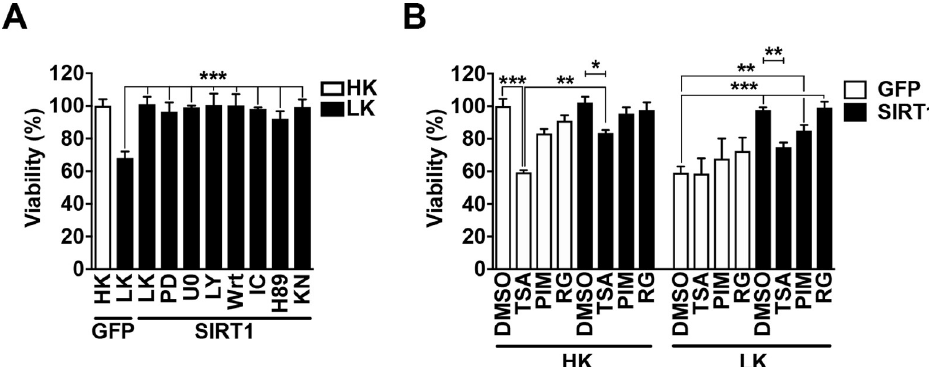
inhibitors: PD98059 (MEK inhibitor), U0126 (MEK inhibitor), LY294002 (PI3-K inhibitor), Wortmannin (PI3-K inhibitor), IC261 (CK1 inhibitor), H89 (PKA inhibitor), KN-62 (CaMKII inhibitor) ( ��� p < 0.001; n = 3). B. CGNs were transfected and treated as described in (A) as indicated with the following inhibitors: trichostatin A (TSA), pimelic diphenylamide 106 (PIM), or RGFP966 ( � p < 0.05, �� p < 0.01, ��� p < 0.001; n = 3).